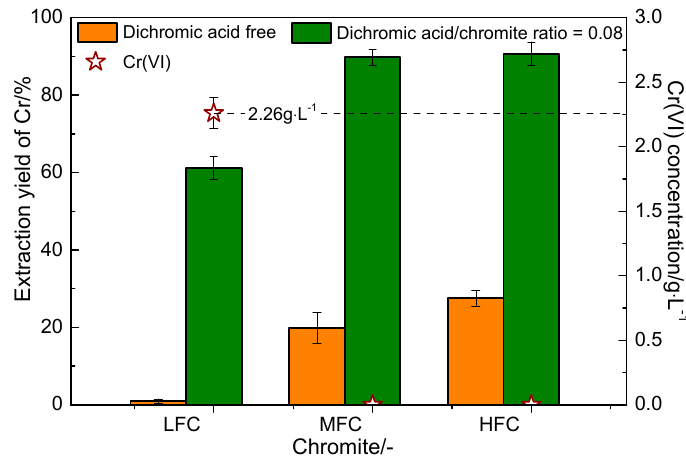
Figure 5. Extraction yields of Cr of di ff erent chromites and final Cr(VI) concentrations in the leachates.